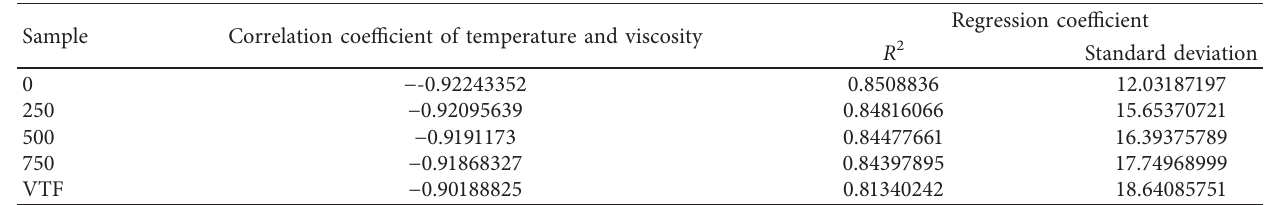
Table 3: Correlation and regression chart of experimental values of viscosity with respect to temperature.